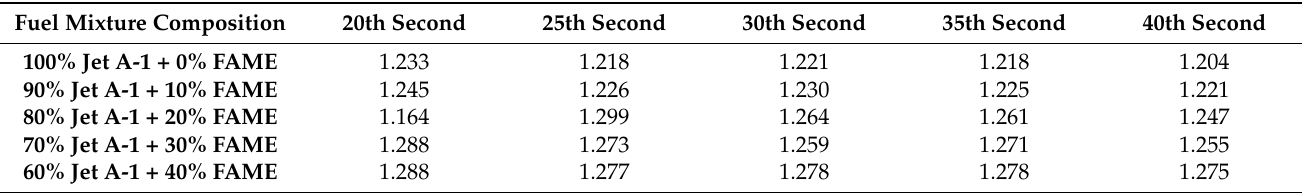
Figure 14. The graphic course of the change in the flow rate of SJE-20 fuel [L.min − 1 ] when using different mixtures of Jet A-1 aviation kerosene and FAME biofuel. Table 19. Change in the flow rate of fuel Qfuel [L.min − 1 ] SJE-20 with different concentrations of Jet A-1 aviation kerosene and FAME biofuel.